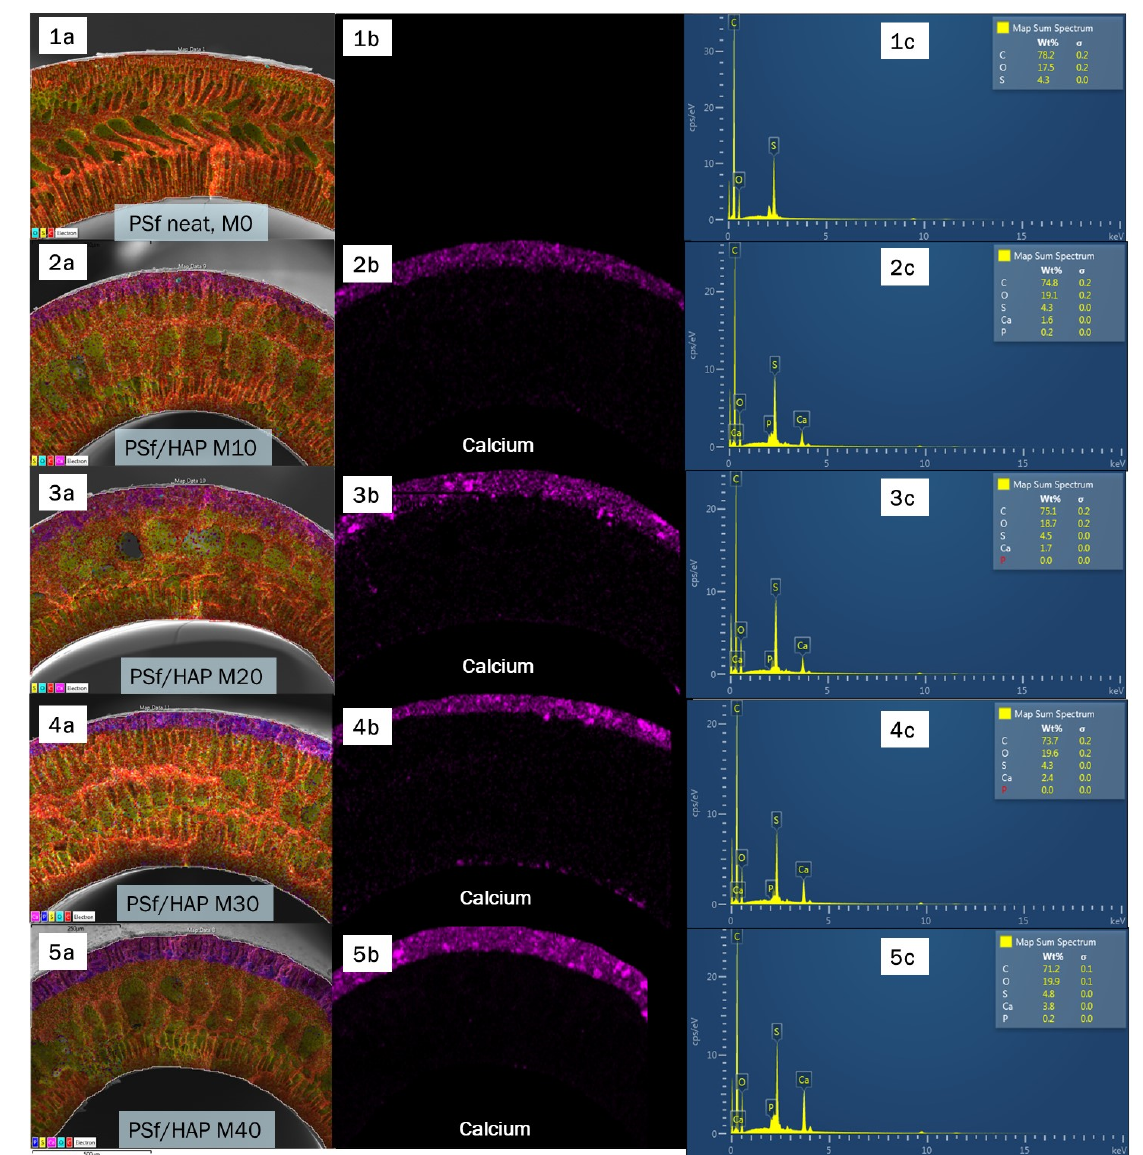
Figure 8. EDX mapping ( a , b ) and point ID ( c ) of neat PSF ( 1 ) and hybrid PSf/HAP DLHF (M10–M40) ( 2 – 5 ) at 250× ( a ) and 500× ( b ) magnification.